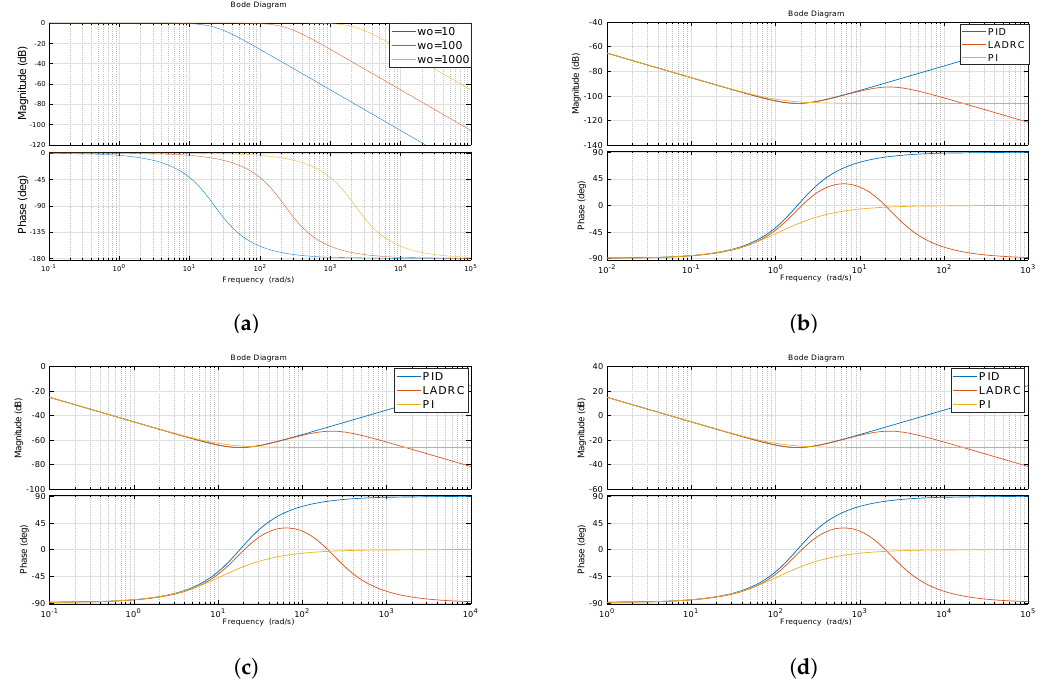
Figure 5. ( a ): Bode diagram of F L ( s ) ; ( b ): Bode diagram of LADRC , PID and PI under ω o = 10; ( c ): Bode diagram of LADRC , PID and PI under ω o = 100; ( d ): Bode diagram of LADRC , PID and PI under ω o =